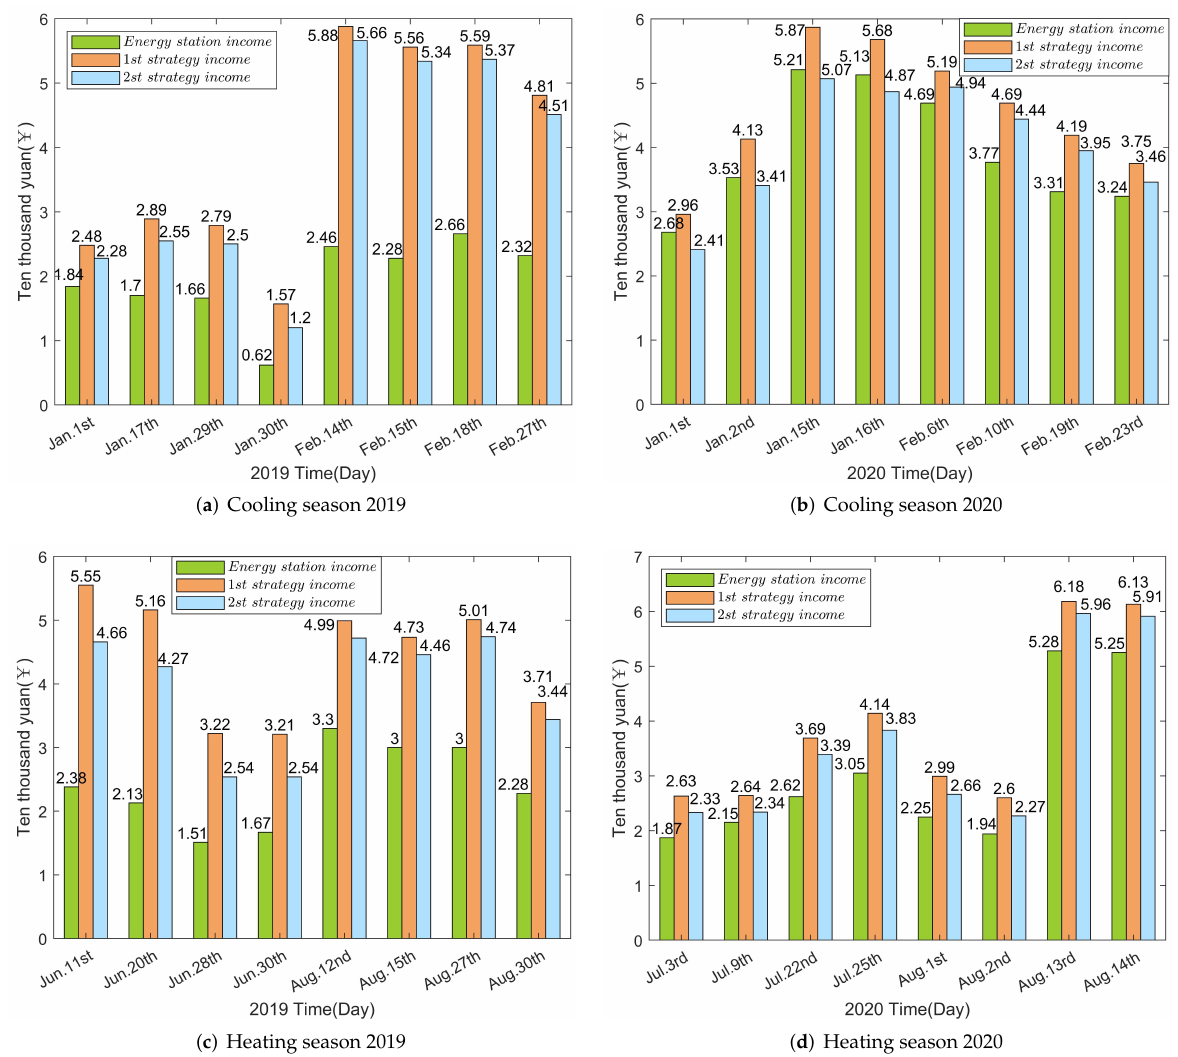
Figure 13. Scheduling optimization results